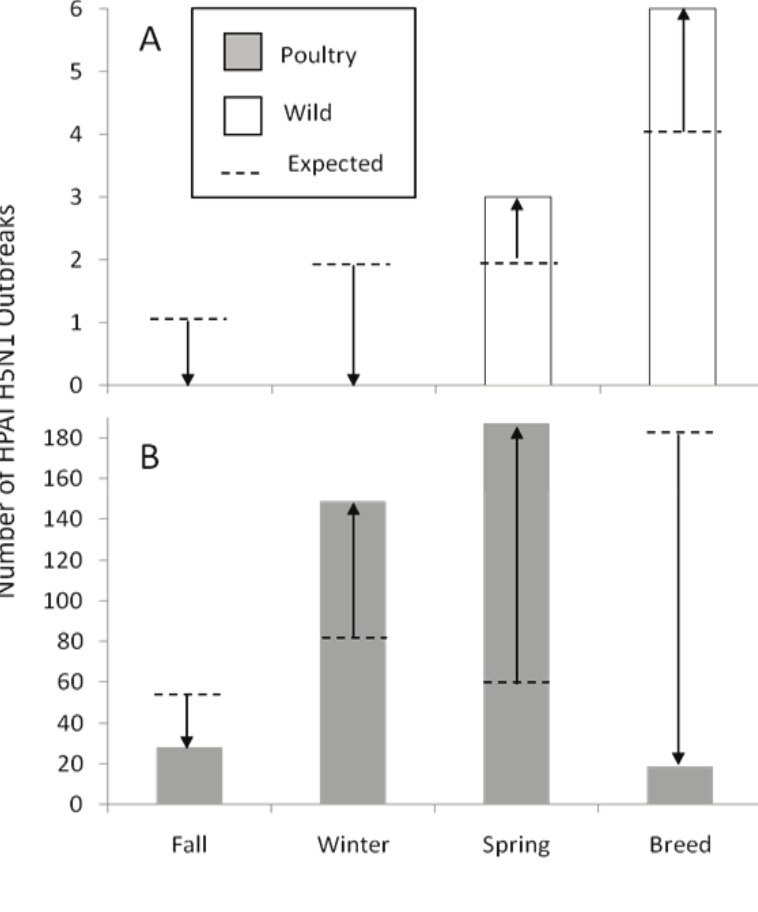
Figure 5. Comparison of wild and domestic outbreaks from 2003 – 2010 by seasonal period in the life cycle of ruddy shelducks. Observed vs. expected values differed for both ( A ) wild bird and ( B ) domestic poultry outbreaks when tested separately (wild: P = 0.043, Fisher Exact Test; poultry: P < 0.0001, Chi-Squared Test). Expected numbers were calculated under the assumption that outbreaks are proportional to the number of days within the fixed seasonal period (fall migration = 55 d; winter = 79 d; spring migration = 56 d; and breeding = 175